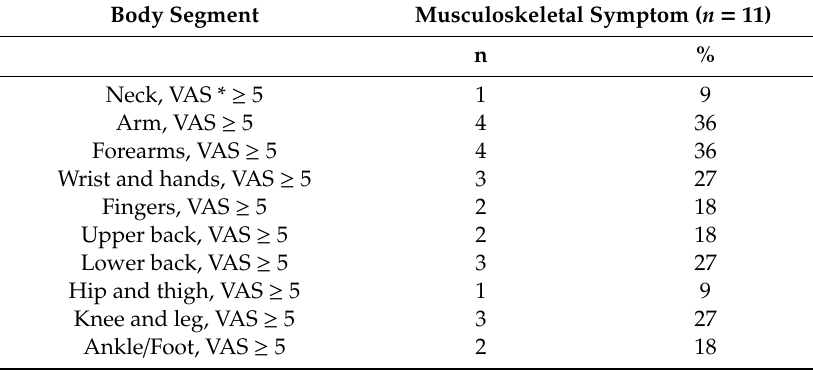
Table 5. The percentage of musculoskeletal symptoms at the time of responding to the questionnaire evaluated using a ten-scale questionnaire ( n = 13; two non-respondents were